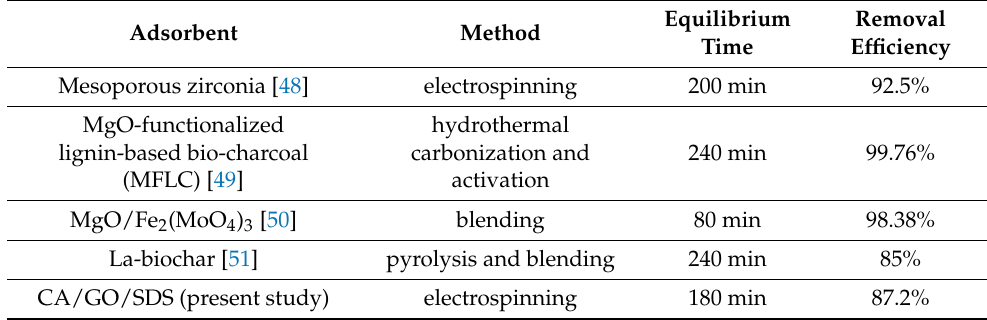
Table 2. Phosphate removal efficiency with various adsorbents.